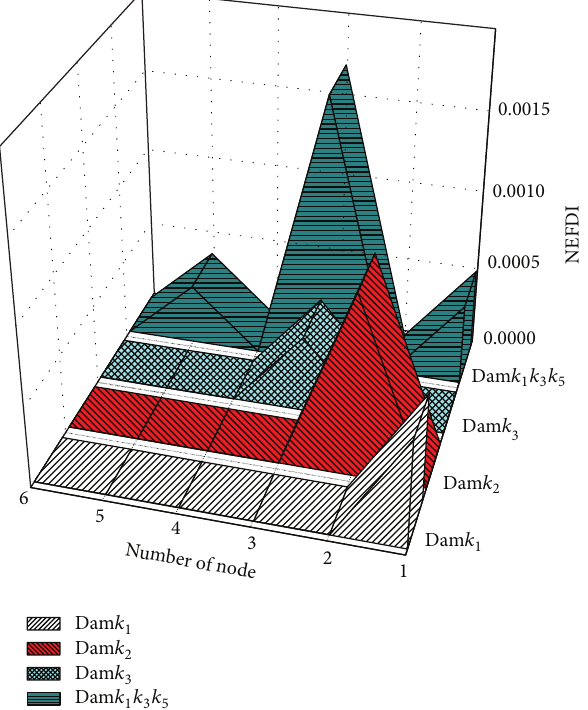
Figure 2: The identified damage locations: (Dam 𝑘 1 ) damaged on 1st storey, (Dam 𝑘 2 ) damaged on 2nd storey, (Dam 𝑘 3 ) damaged on 3rd storey, and (Dam 𝑘 1 𝑘 3 𝑘 5 ) damaged on 1st, 3rd, and 5th storey.